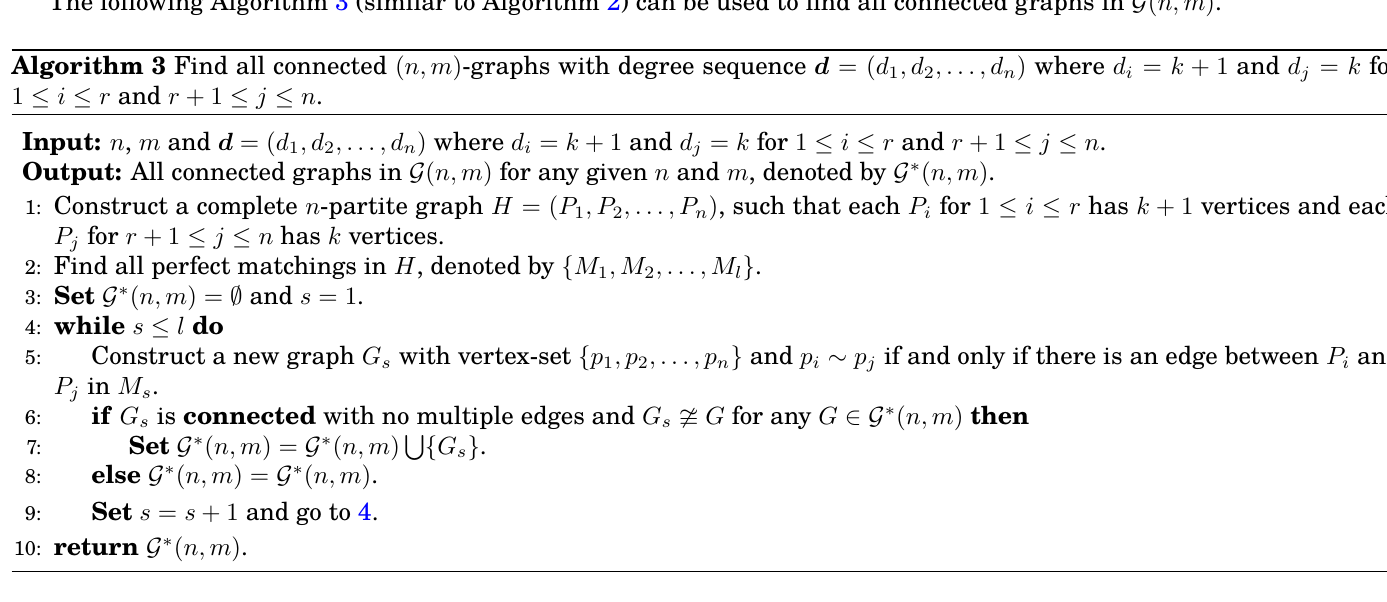
Algorithm 3 Find all connected ( n, m ) -graphs with degree sequence d = ( d 1 , d 2 , . . . , d n ) where d i = k + 1 and d j = k for 1 ≤ i ≤ r and r + 1 ≤ j ≤ n